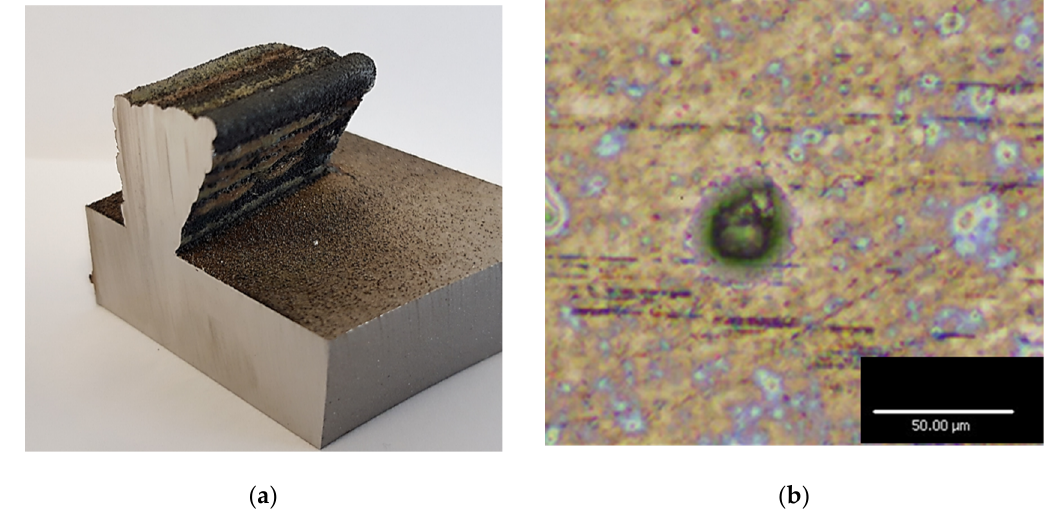
Figure 15. Results: ( a ) variable thickness wall cut in different cross sections for analyzing the structure and the geometrical dimensions; ( b ) pore of less than 25 µm.